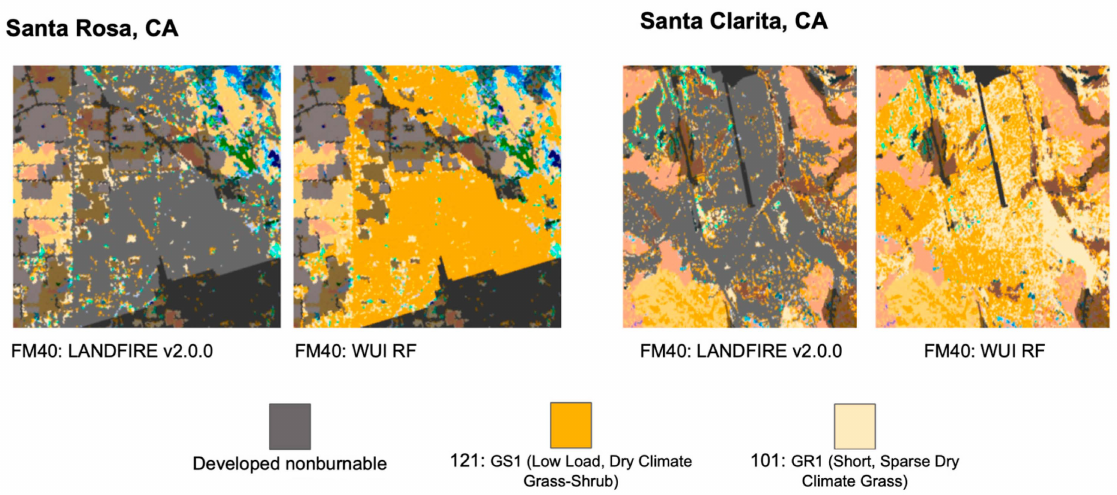
Figure 6. Classification of building structures from unburnable to burnable fuel